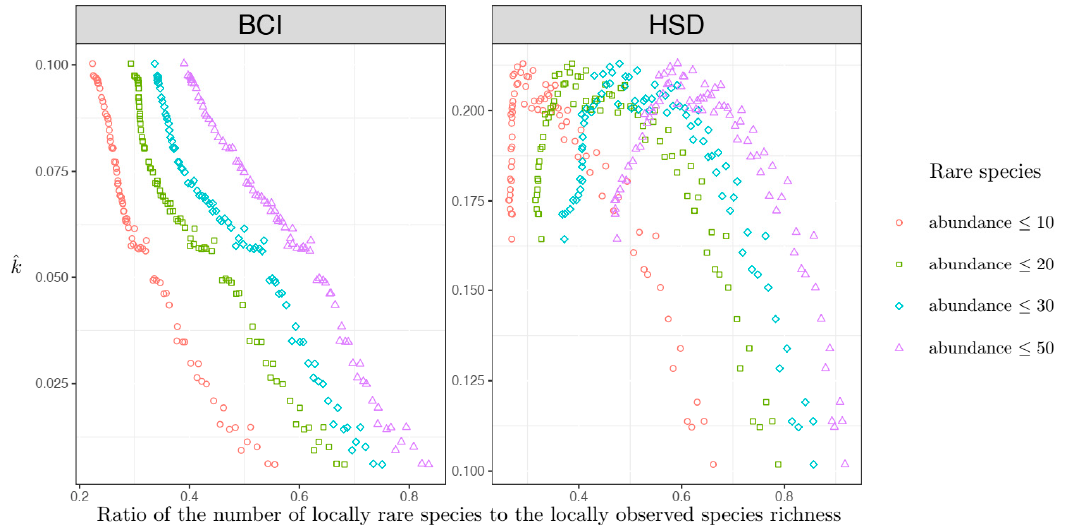
Figure 2. Multiscale relationships between the shape parameter k estimated from the randomly sampled local communities and the percent of locally rare species (defined as a local population size or abundance ≤ 10, 20, 30, and 50) in these sampled communities for the Barro Colorado Island (BCI) plot and the Heishiding (HSD) plot. Forests 2020 , 11 , x FOR PEER REVIEW